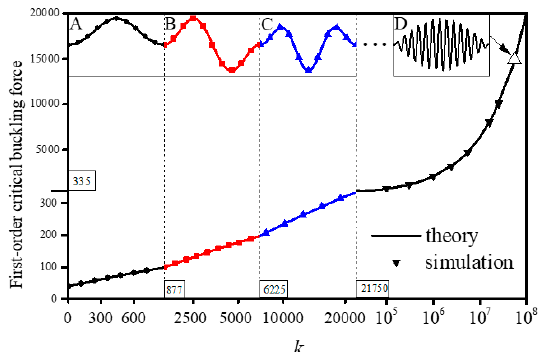
Figure 3. The first-order critical buckling force versus substrate stiffness comparison between theory and simulation when P = 10 6 . The first-order buckling mode with ( A ) k = 0~877, ( B ) k = 877~6225, ( C ) k = 6225~21,750, and ( D ) when k = 5.5 × 10 7 .